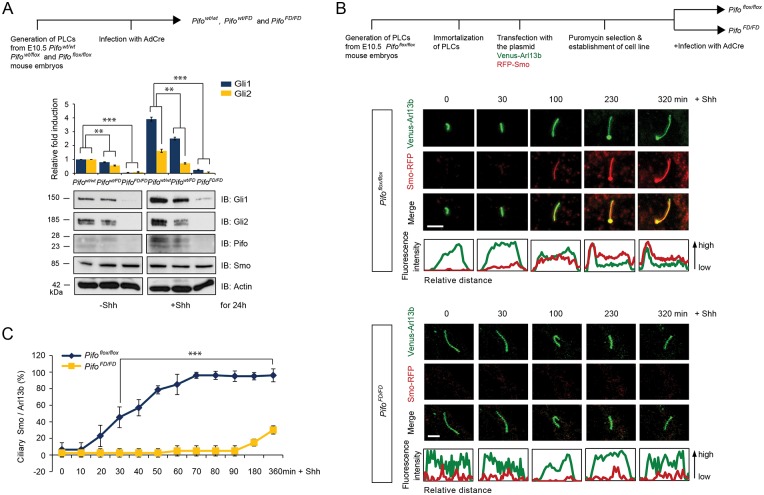
Pifo is necessary for Shh target gene activation and translocation of Smo into the PC.(A) The levels of Gli1 and Gli2 protein in Pifowt/wt, Pifowt/FD, and PifoFD/FD PLCs treated with or without Shh. Graphs represent quantification of immunoblot data that show the mean fold change of protein normalized to Actin levels. (B) Immortalization and generation of stably transfected Pifoflox/flox PLCs to analyze the requirement of Pifo in Smo ciliary translocation by quantitative live-cell imaging. Selected still images (B) and quantification (B, C) of confocal time-lapse movies of Pifoflox/flox PLCs and PifoFD/FD PLCs stably expressing Venus-tagged Arl13b and RFP-tagged Smo. Scale bar = 5 μm. >100 cilia per condition were analyzed. All error bars indicate the mean ± SD of three independent experiments. Data were analyzed using a two tailed unpaired t-test (** = p<0.01, *** = p<0.001)